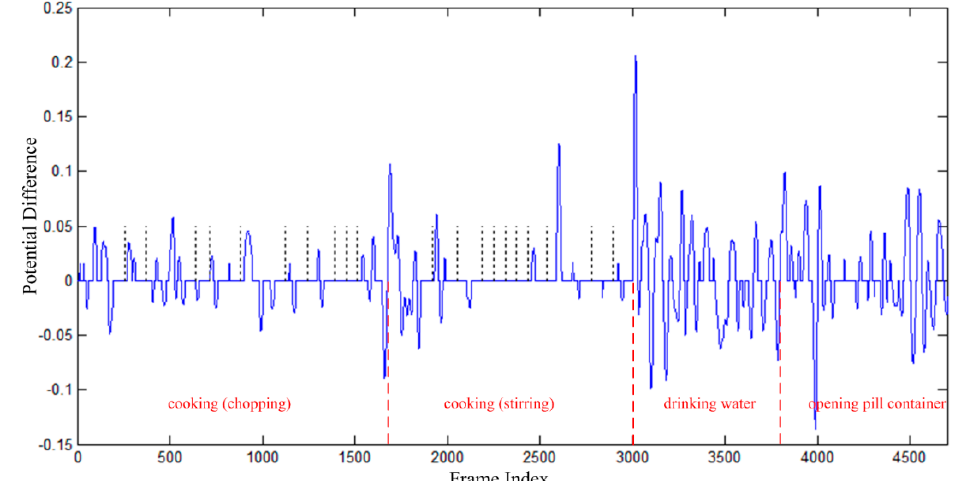
Figure 7. Segmentation results of one continuous data sequence. (The blue curves denote motion feature segments, the blue horizontal lines between each two blue curve parts indicate the pose feature segments, the black vertical dotted lines indicate the boundaries of pose feature segments, the red vertical dashed lines indicate the boundaries of different kinds of human actions.)